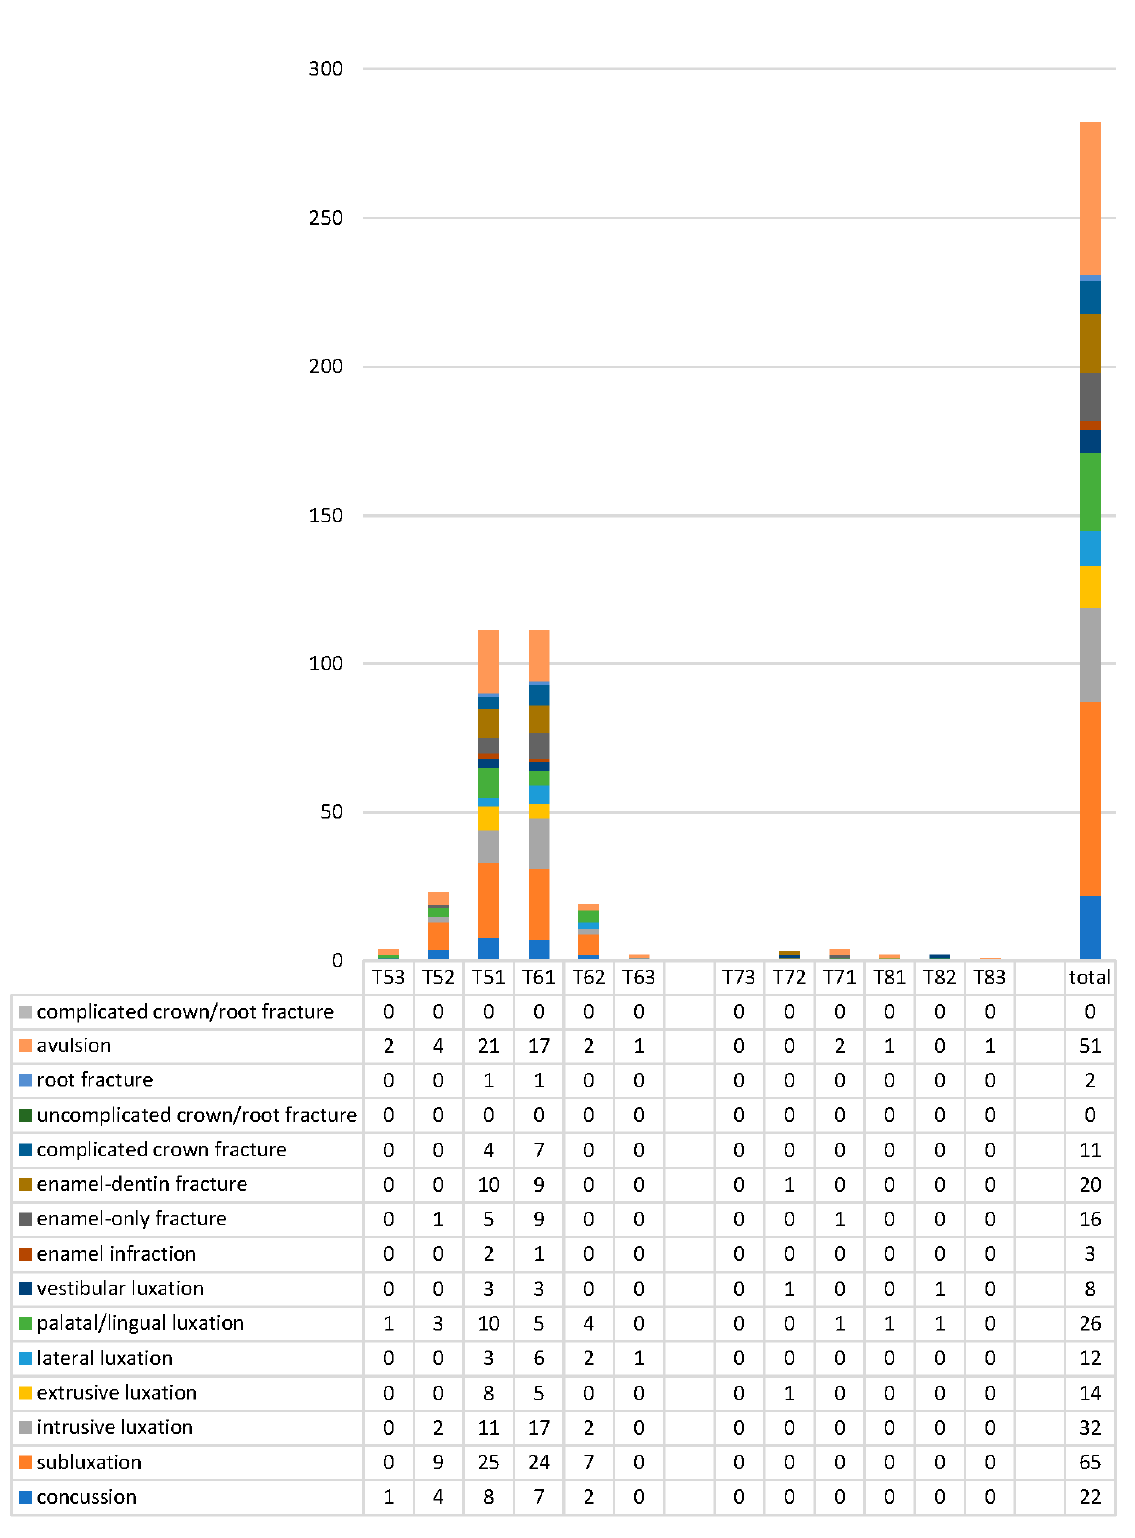
Figure 3. Distribution and types of injuries for deciduous teeth. T53 stands for tooth 53, etc.